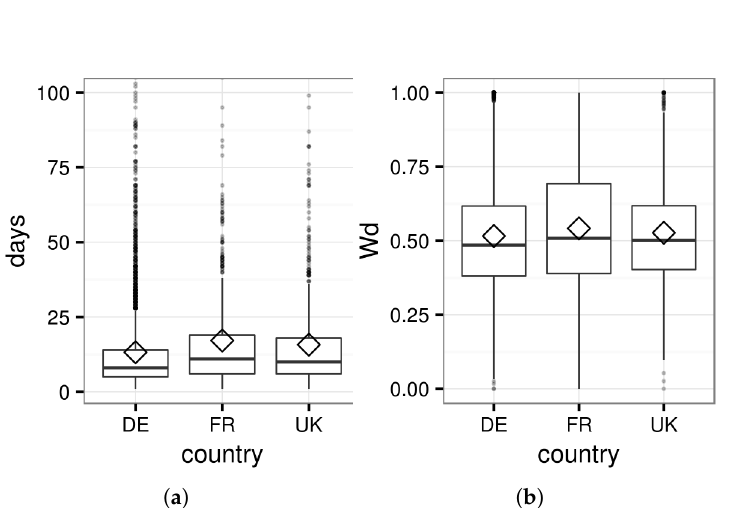
Figure 5. Distributions of motivation indicators. ( a ) Longest streak; ( b ) weekday versus